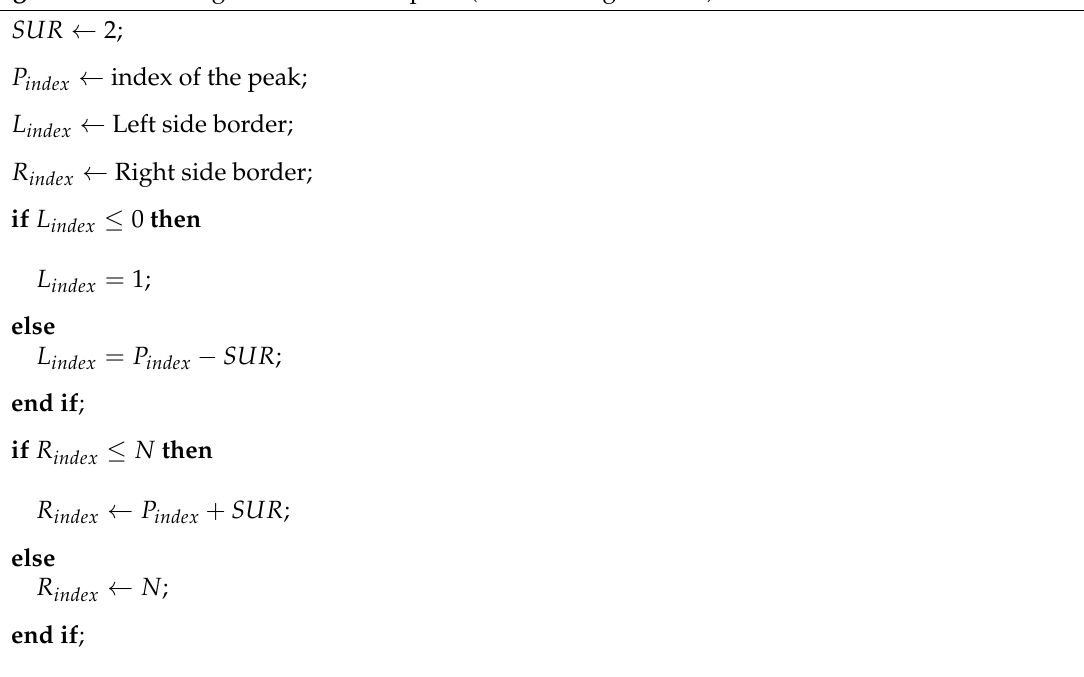
Algorithm 1 Defining the borders of a peak (surrounding